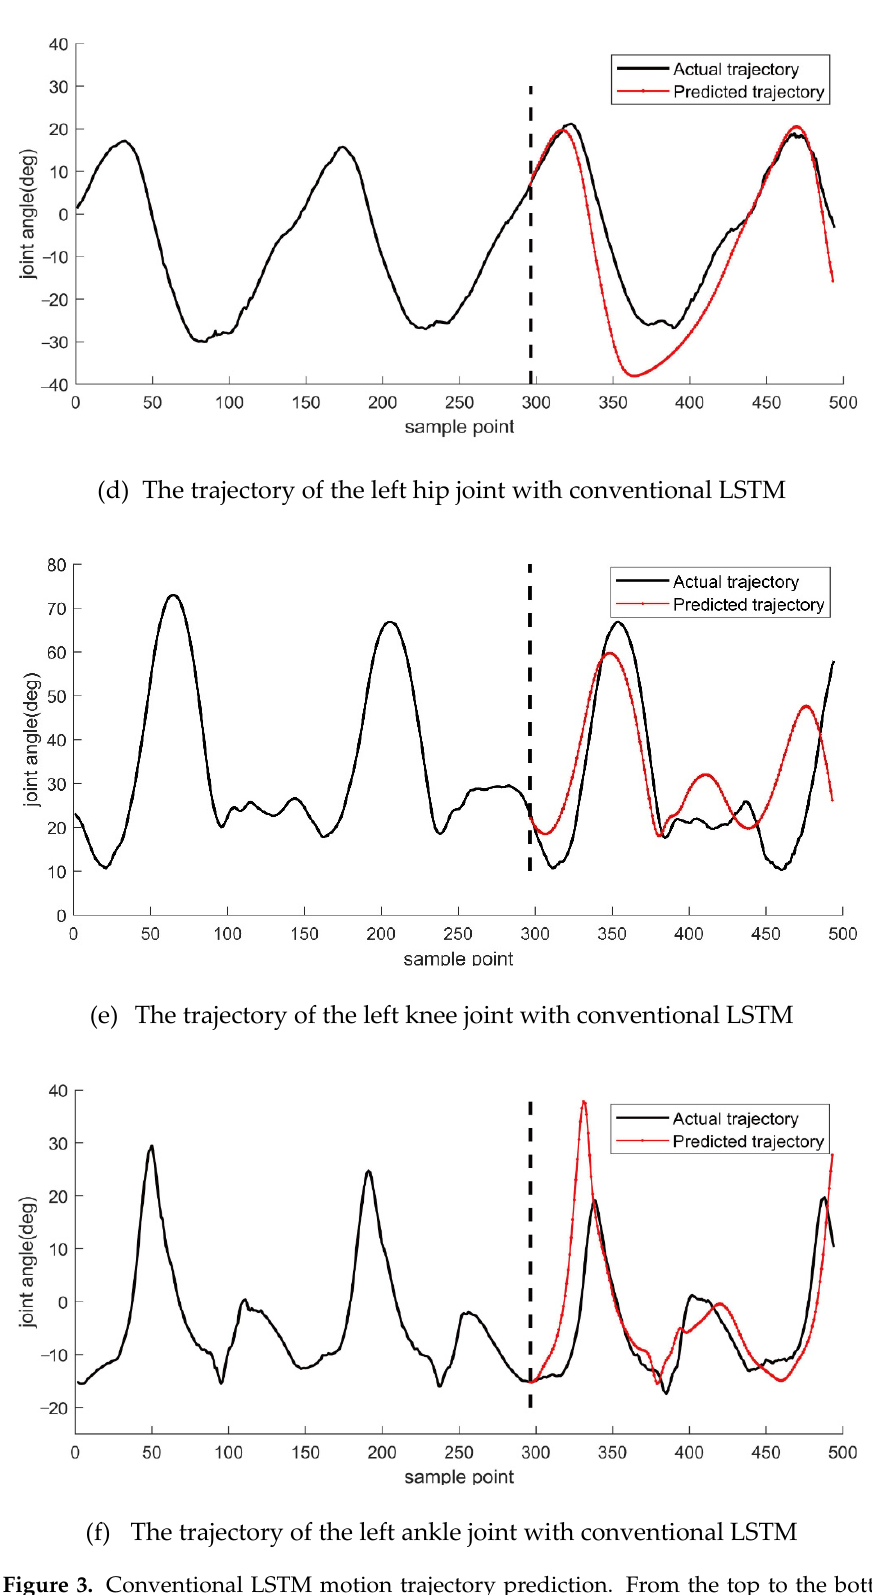
Figure 3. Conventional LSTM motion trajectory prediction. From the top to the bottom are the trajectories of the right hip, right knee, right ankle, left hip, left knee, and left ankle joints. From the data in Figure 3, we can observe that the predicted motion trajectories of the left and right legs at the hip, knee, and ankle joints on both sides of the lower limb are significantly different. The predicted motion trajectories of the left and right legs at the